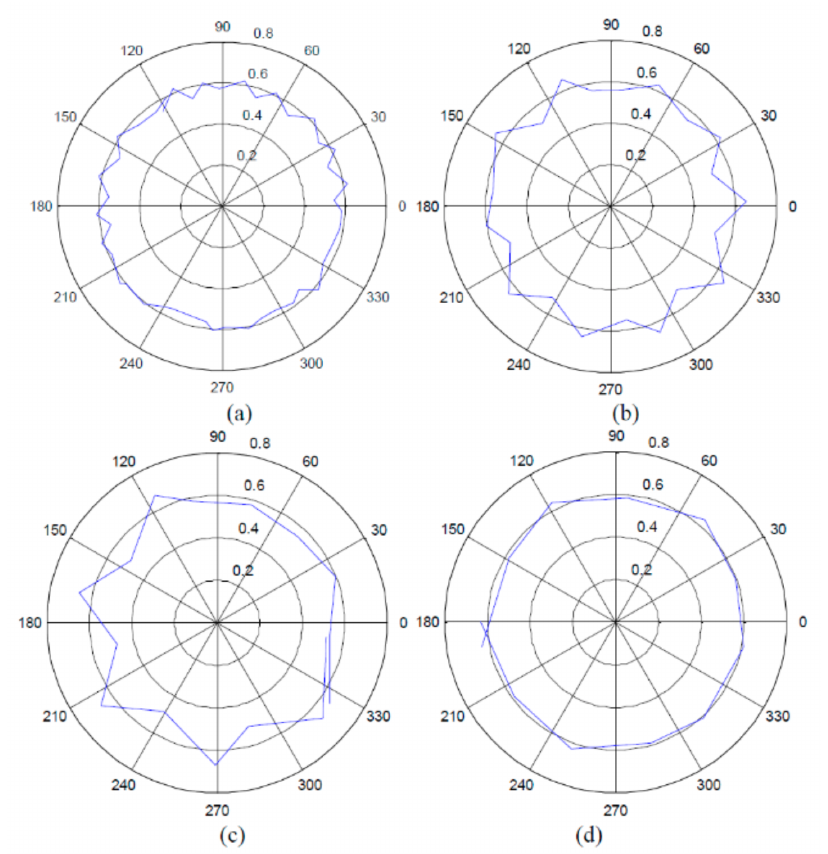
Figure 36. Spindle error motion for the operational speeds of ( a ) 25 rpm, ( b ) 50 rpm, ( c ) 75 rpm, and ( d ) 100 rpm